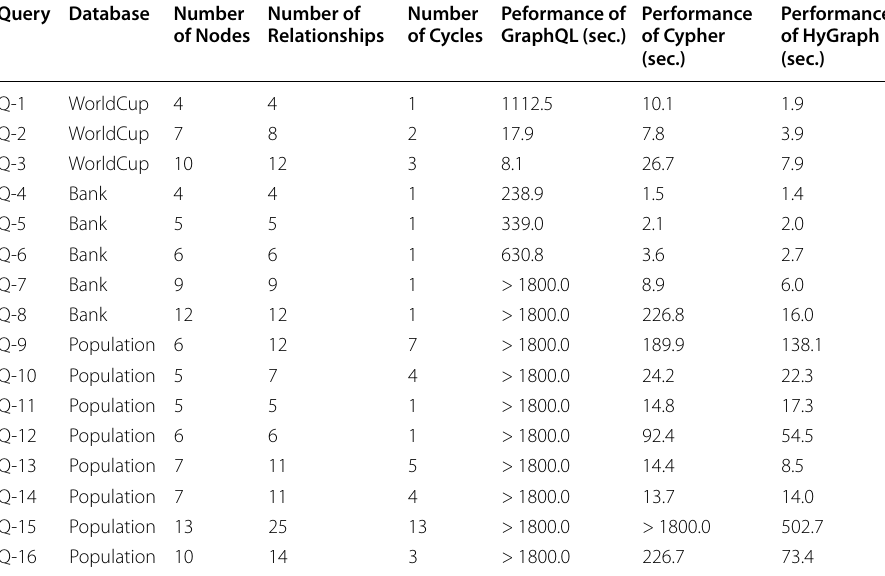
The timings are given in terms of seconds